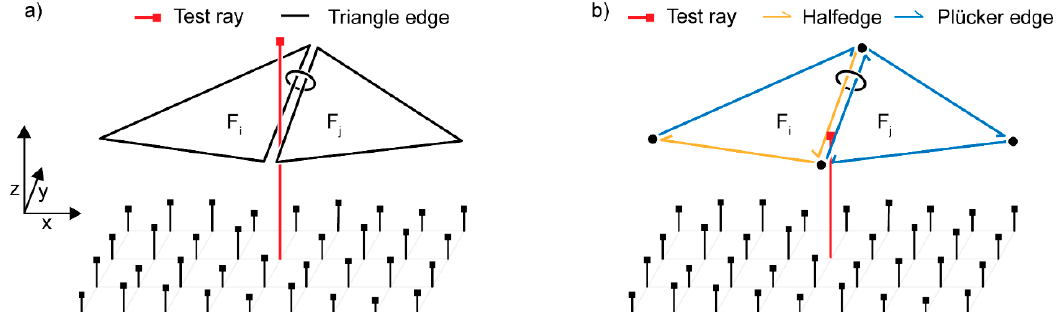
Figure 6. Schematic depiction of a problematic scenario during triangle ray intersections ( a ) where ray-intersections could slip through adjacent triangles F i and F j due to numerical inaccuracies ( b ) with the unambiguous determination of the cut triangle by using Plücker representations of edges.